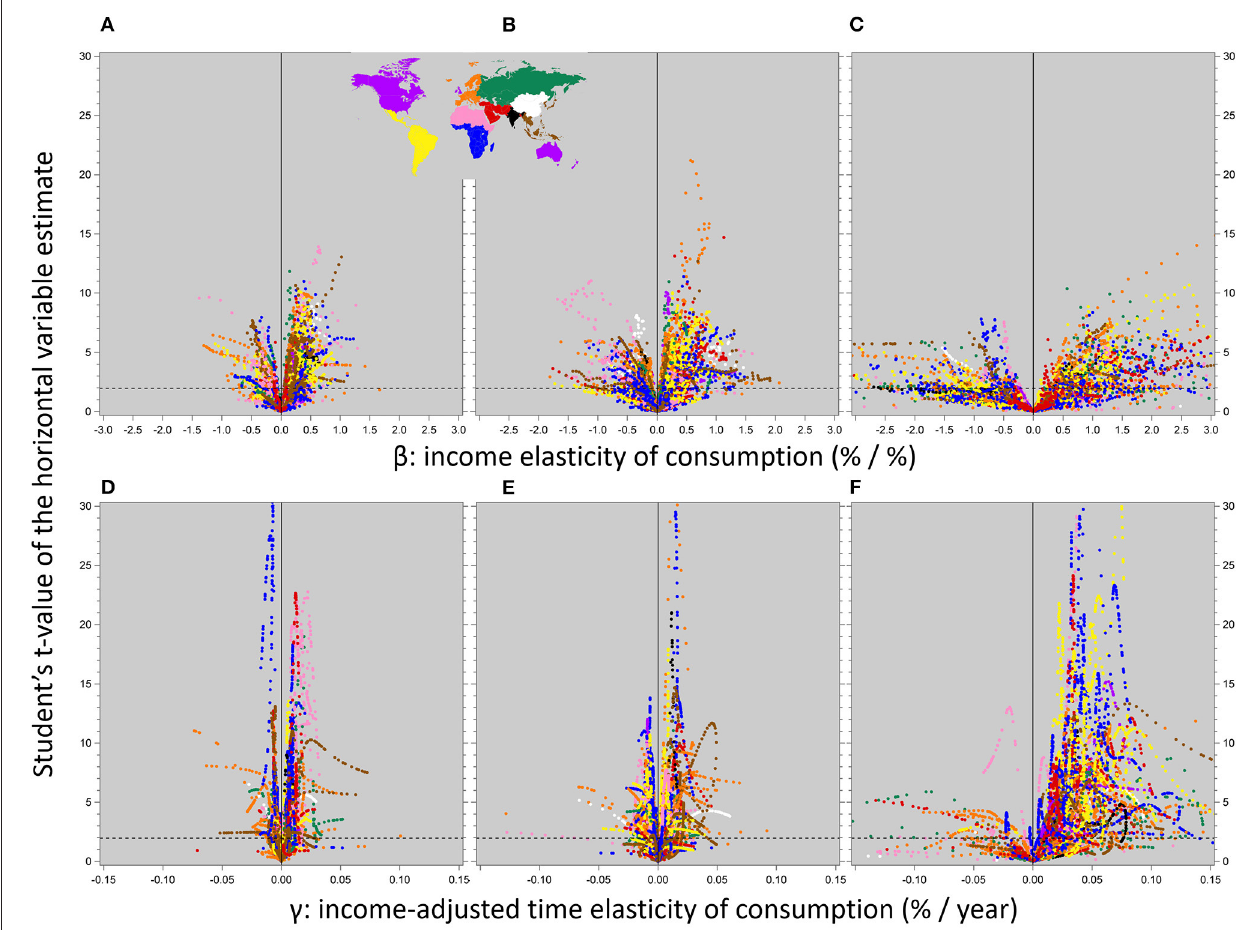
FIGURE 5 | The β and γ elasticity estimates of total protein consumption (A,D) and of the contributions of animal source food (B,E) and poultry meat (C,F) to it on the x-axes, and the absolute values of their bootstrapped Student’s t-values on the y-axes. The dotted horizontal reference lines indicate the 95% significance level: estimates below these lines do not differ significantly from zero. Each datapoint represents a country-year-combination.